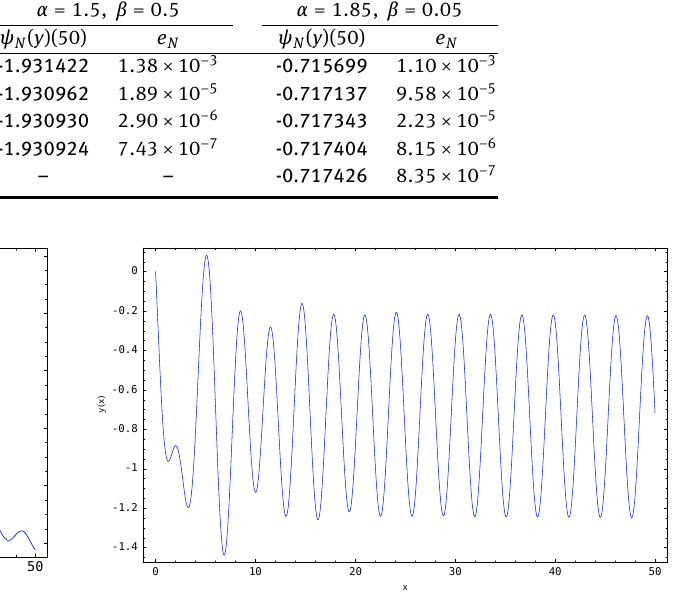
Table 8: The values of ψ N ( y )(50) and e N for various values of α and β for Example 5. α = 1.2, β = 0.8 α = 1.5, β = 0.5 α = 1.85, β = 0.05